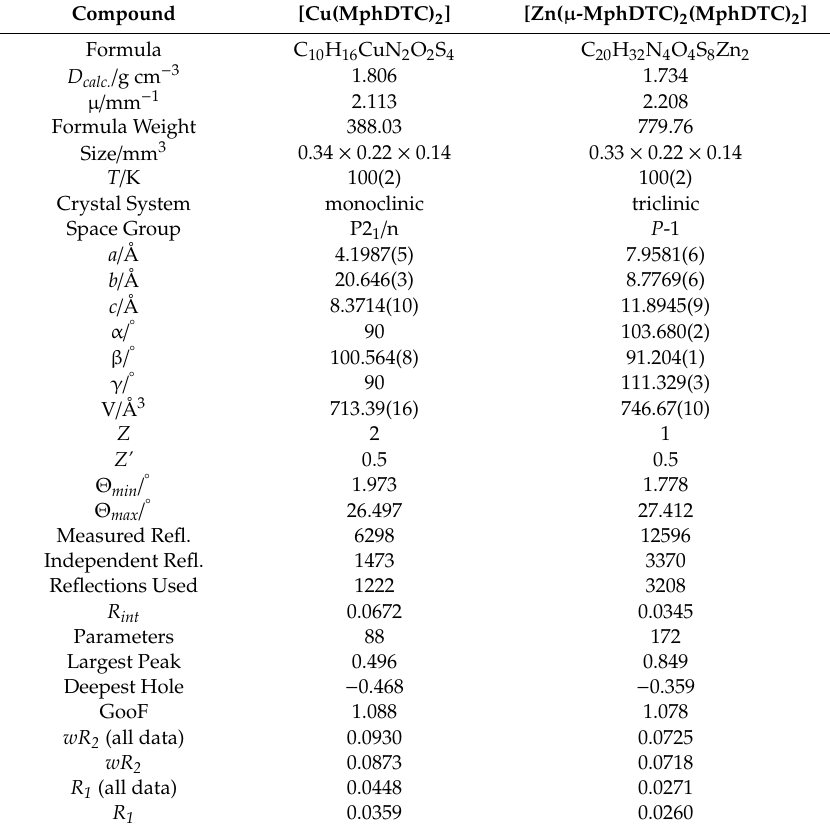
Table 1. Crystallographic data and structure refinements for the complexes.